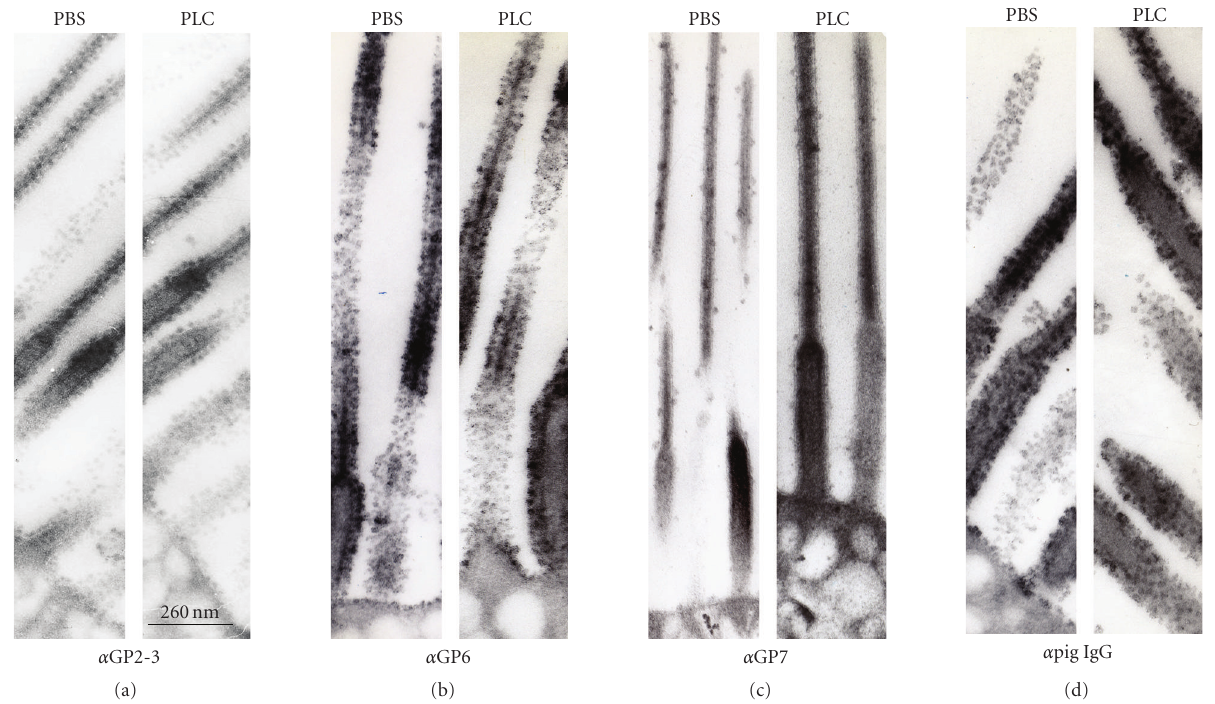
Figure 3: Tegument surface of Taenia solium cysticerci, after 1 hour incubation with PBS or PLC. Sections of the bladder wall of cysticerci were incubated with the IgG fraction of (a) anti-GP2-3, (b) anti-GP6, (c) anti-GP7, and (d) anti-pig IgG.